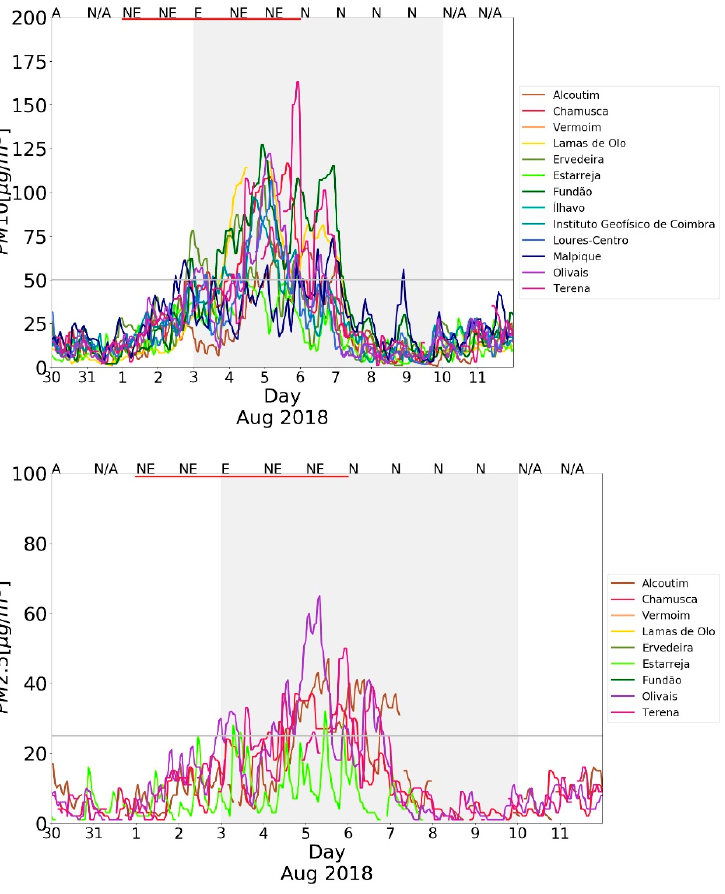
Figure 8. Similar to Figure 6, but for August 2018. The Monchique fire occurred over 3rd and 10th of